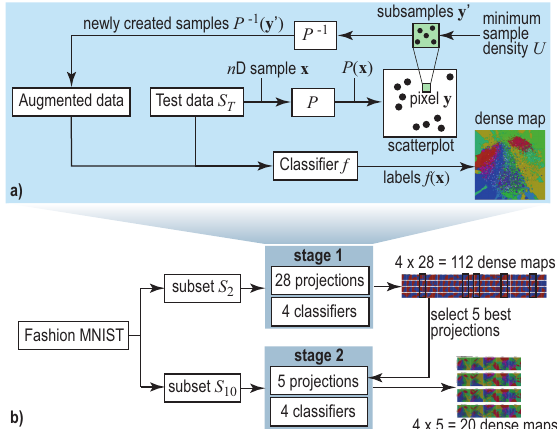
Figure 1. ( a ) Dense map construction algorithm; ( b ) Two-phase experiment